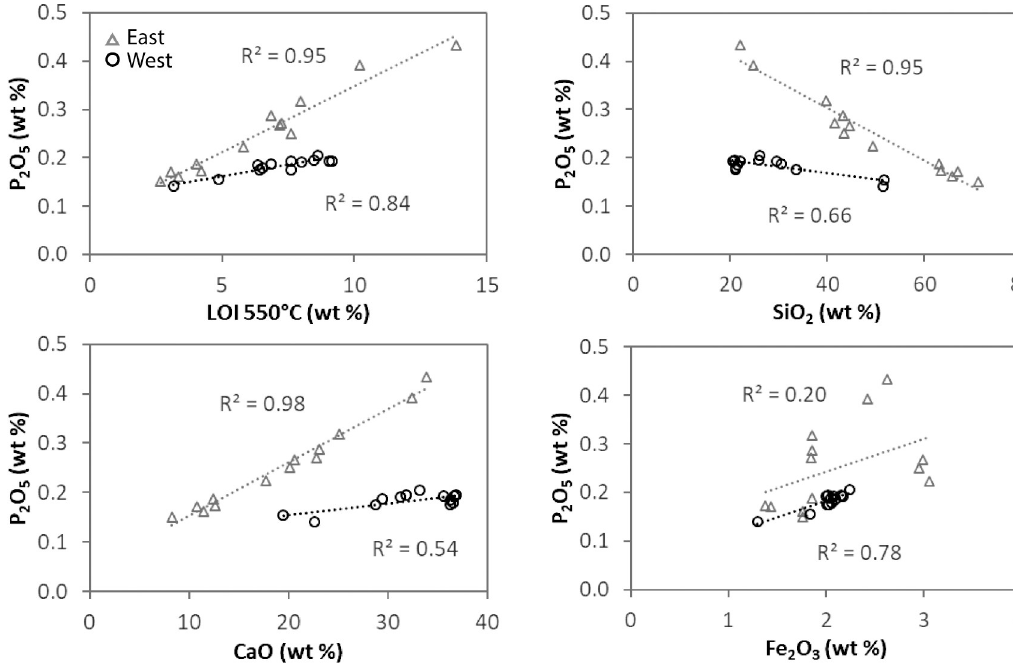
Fig 2. P 2 O 5 abundance versus LOI 550˚C, CaO, and SiO 2 . LOI 550˚C is a measure of organic matter concentration. West samples ( n = 13) were collected from sites 2–3, 5–10, and 14 and east samples ( n = 13) were collected from sites 1, 4, 11–13, and